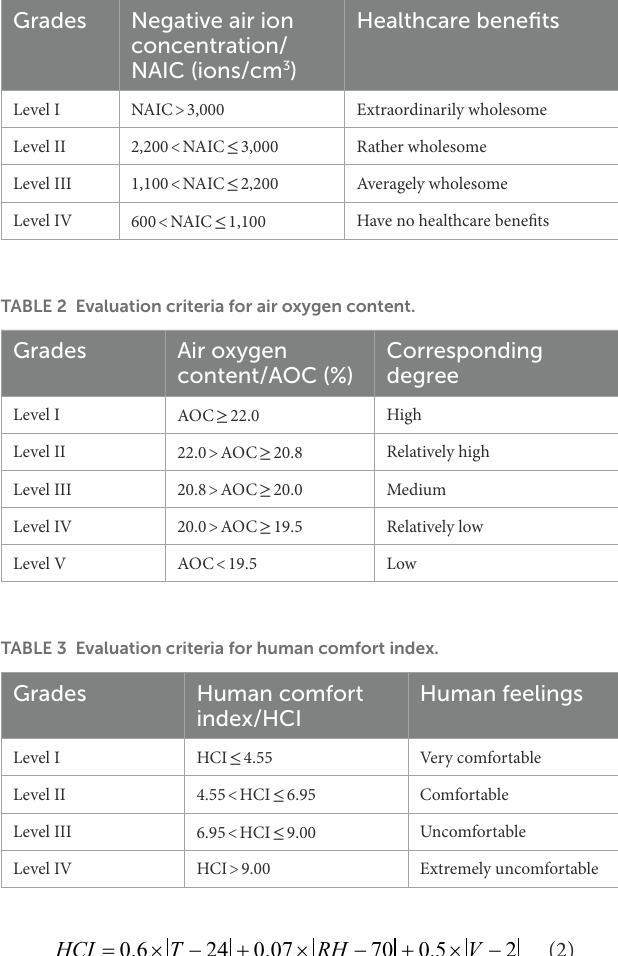
TABLE 1 Evaluation criteria for negative air ion concentration.